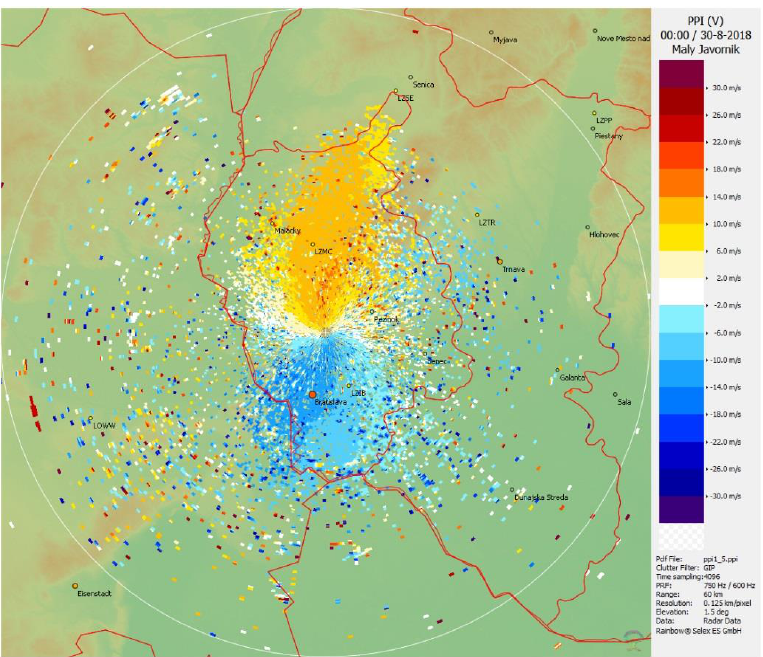
Figure 7. The same event as in Figure 5 but seen by the radar at Malý Javorník and displayed in terms of the radial wind speed in the PPI regime under an elevation angle of 1.5° at 00:00 UTC. Note that in contrast with the lidar, wind blowing towards the radar is defined as negative. The location of the Bratislava Airport is indicated by ‘LZIB’, in the SSE direction from the radar.